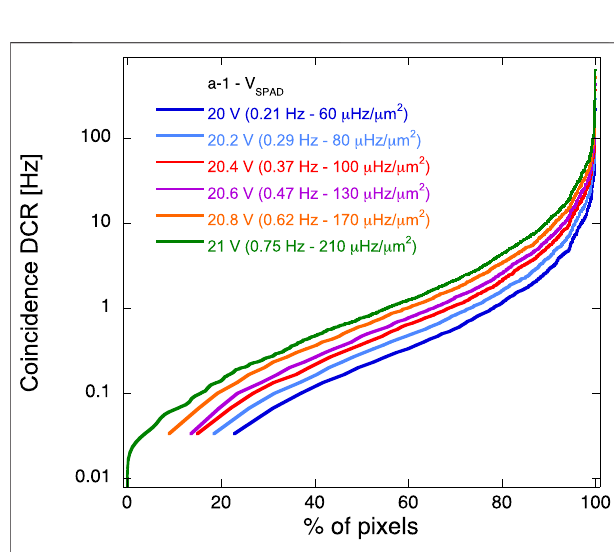
FIGURE10| DCR cumulative distribution curves forpixelsfromdifferent array structures in different single-layer samples.